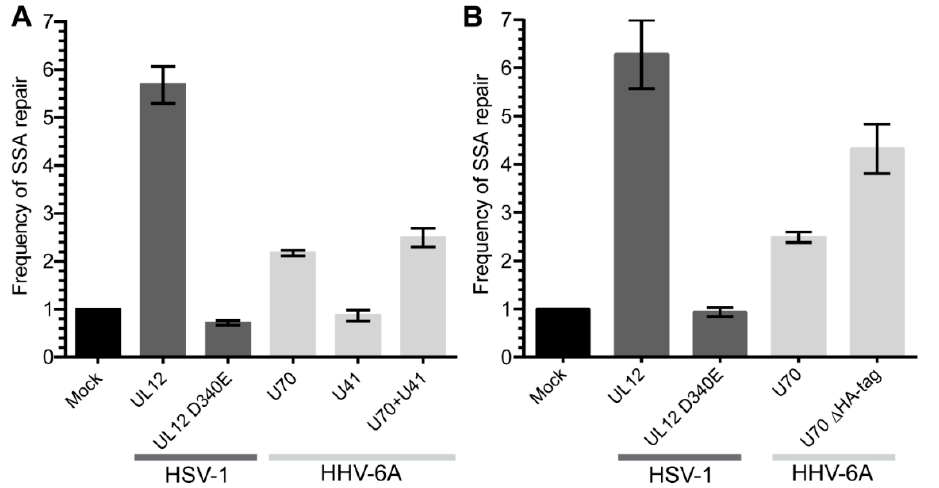
Figure 1. The role of HHV-6A U70 and U41 in double strand DNA break repair by single strand annealing (SSA). ( A ) An SSA reporter was integrated into 293T cells and the cells were transfected with the indicated expression plasmids. The frequency of repair was calculated and normalized to the mock transfected cells (control plasmid). Displayed are the mean frequency of repair for each transfected construct ( n = 3 ± SEM). ( B ) The C-terminal HA-tag on U70 was removed and the same assay as in ( A ) was performed ( n = 3 ± SEM).